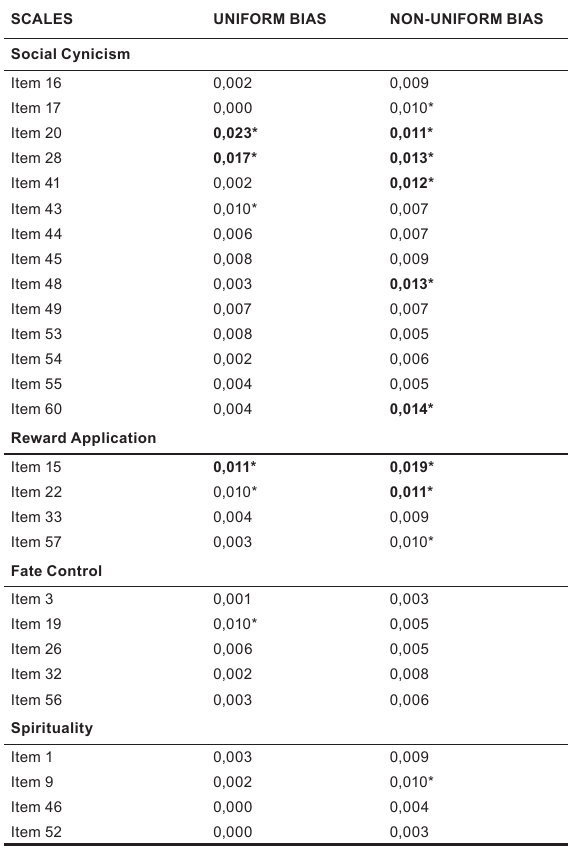
tABLe 4 Items with small (< 0,01) effect size bias and significance of four SAS factors for the different language